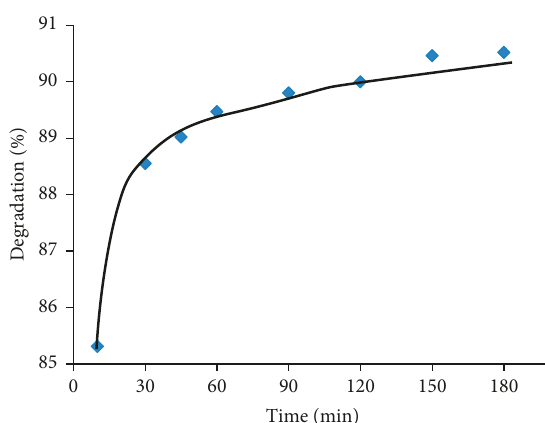
Figure 8: Effect of time on the degradation percentage of MB.